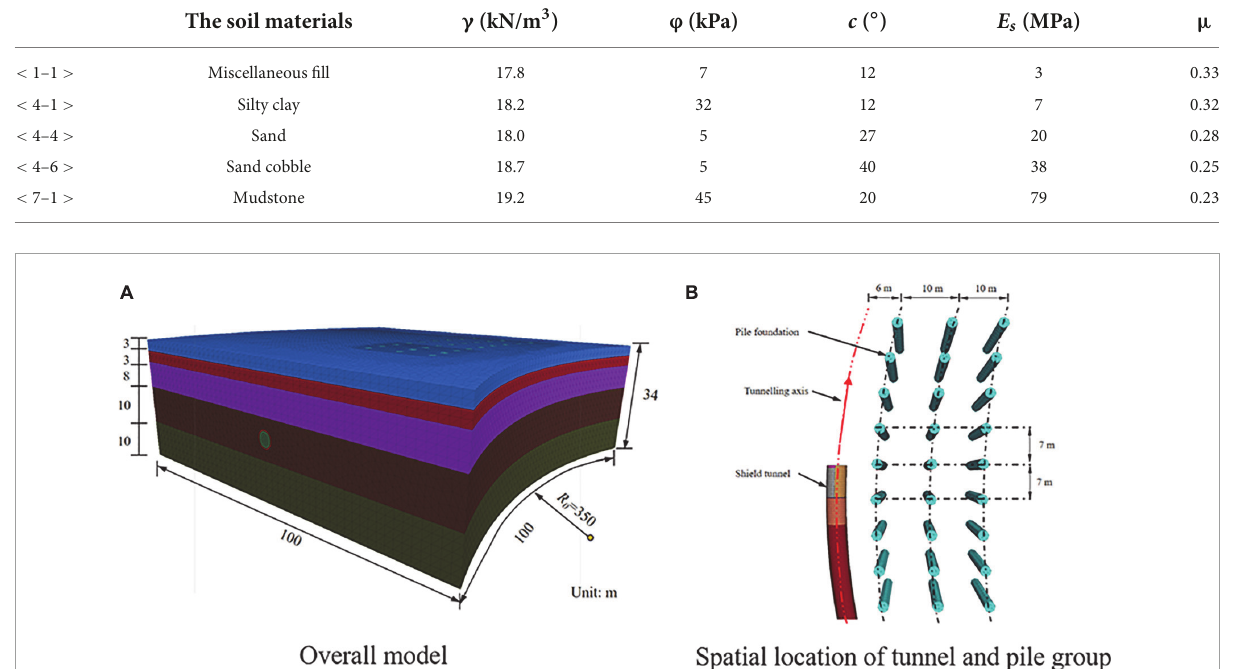
TABLE 1 Mechanical parameters of soil layer.